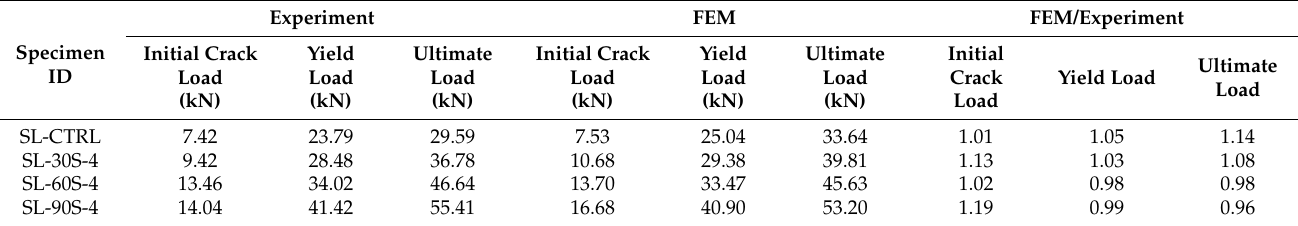
Table 1. Comparison of experimental and numerical